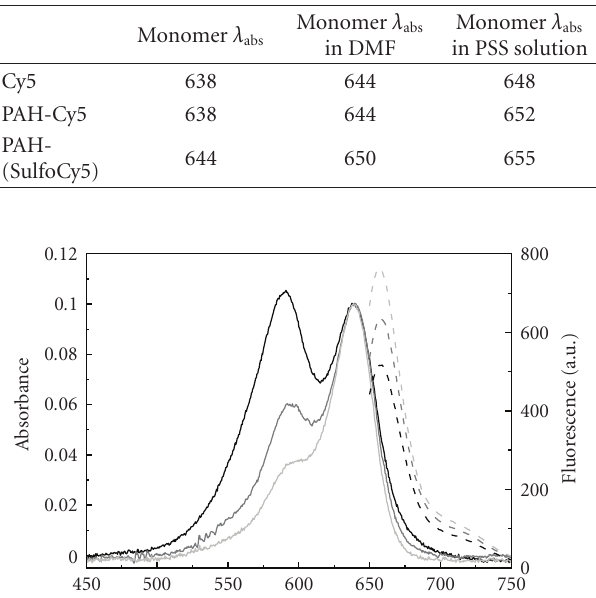
Table 1: Shift of absorption maxima λ abs (in nm) of Cy5 monomer band in di ff erent media.